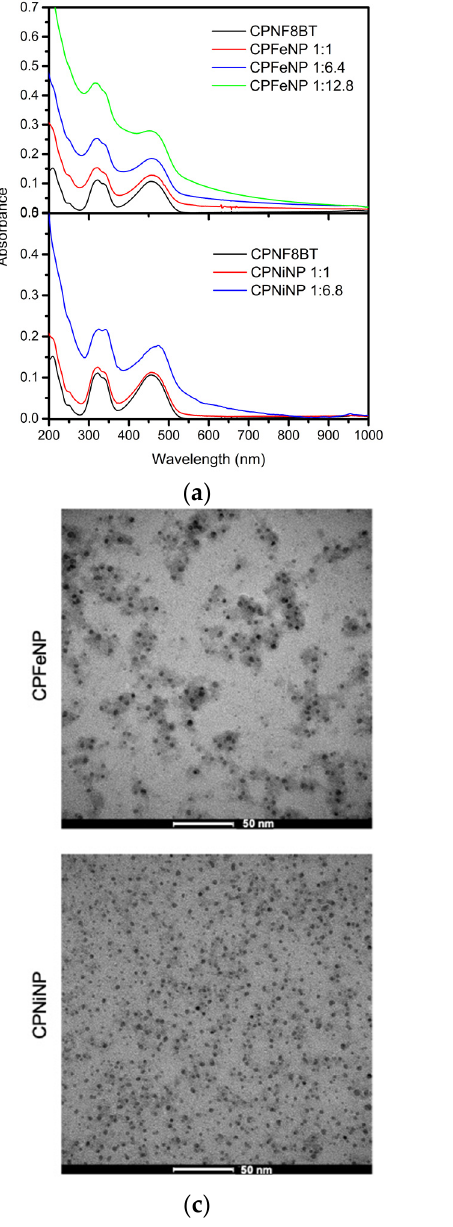
Figure 1. Characterization of IONP-doped CPNs. ( a ) Absorption spectra of CPFeNP (upper panel) and CPNiNP (lower panel) at different CP:IONPs mass ratios in water. ( b ) Emission spectra of CPFeNP (upper) and CPNiNP (lower) at different CP:IONPs mass ratios in water.( c ) Representative TEM images of CPFeNP (upper) and CPNiNP (lower). ( d ) Size distribution histograms of CPFeNP (upper) and CPNiNP (lower).